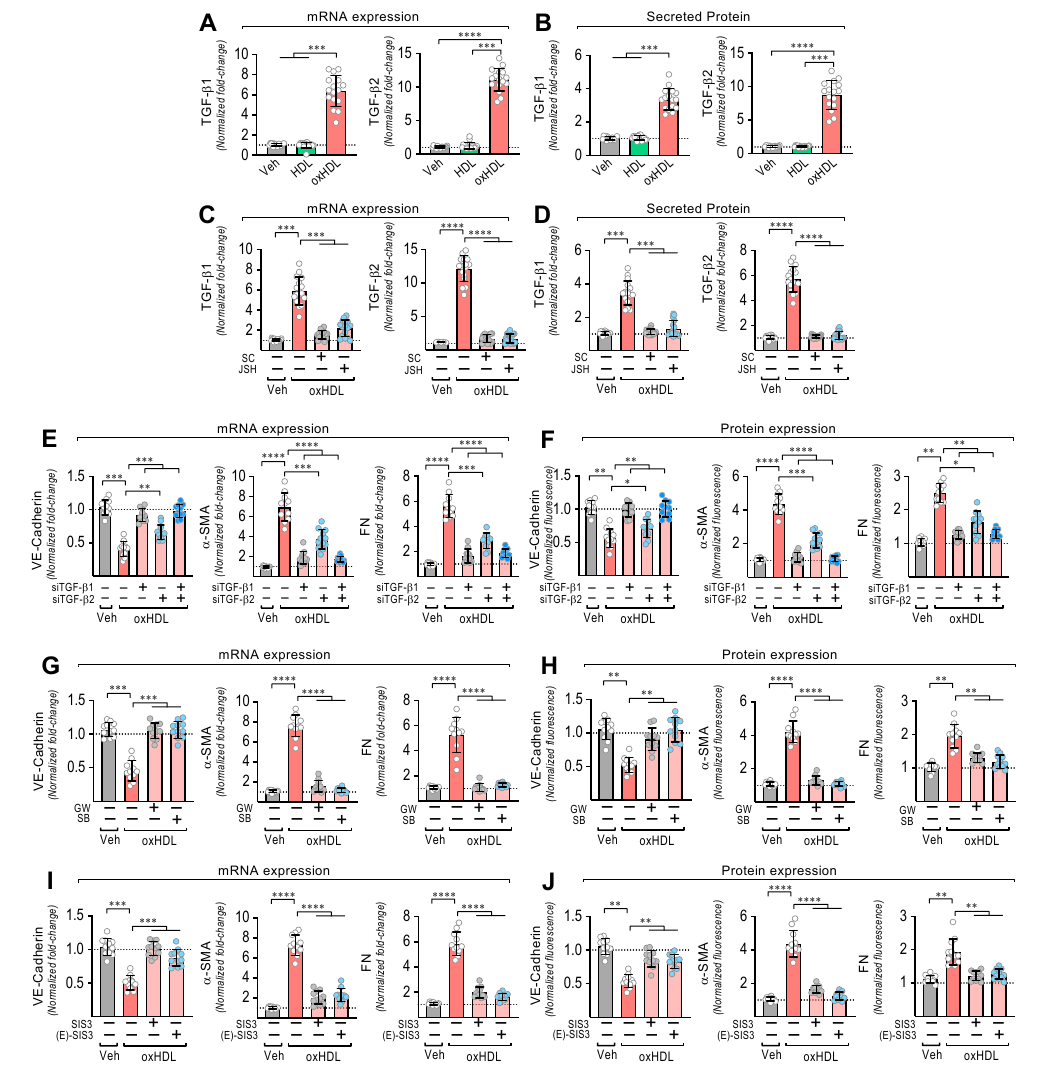
Figure 2. OxHDL induces endothelial fibrosis through the TGF- β 1/2 secretion/ALK-5/Smad protein pathway. ( A , B ) ECs were exposed to vehicle, HDL 50 µ g/mL, and oxHDL 50 µ g/mL for 48 h, and mRNA expression ( A ) and protein secretion ( B ) of TGF- β 1 (left panels) and TGF- β 2 (right panels) were measured. ( C , D ) ECs were exposed to vehicle and oxHDL 50 µ g/mL for 48 h in the absence or presence of the NF- κ B inhibitors SC-3060 (5 µ M) and JSH-23 (30 µ M), and mRNA expression ( C ) and protein secretion ( D ) of TGF- β 1 (left panels) and TGF- β 2 (right panels) were measured. (N = 11). ( E , F ) ECs were transfected with specific siRNA against TGF- β 1 (siTGF- β 1) and TGF- β 2 (siTGF- β 2) or non-transfected for 72 h, and then, cells were exposed to vehicle and oxHDL 50 µ g/mL for 48 h, and mRNA ( E ) and protein ( F ) expression of VE-cadherin (left panels), α -SMA (middle panels), and FN (right panels) was measured. (N = 16). ( G , H ) ECs were exposed to vehicle and oxHDL 50 µ g/mL for 48 h in the absence or presence of the ALK-5 inhibitor GW-788388 (5 µ g/mL) and SB-431542 (30 µ M), and mRNA ( G ) and protein ( H ) expression of VE-cadherin (left panels), α -SMA (middle panels), and FN (right panels) was measured. (N = 16). ( I , J ) ECs were exposed to vehicle and oxHDL 50 µ g/mL for 48 h in the absence or presence of the Smad3 inhibitor SIS3 (10 µ M) and (E)- SIS3 (5 µ M), and mRNA ( I ) and protein ( J ) expression of VE-cadherin (left panels), α -SMA (middle panels), and FN (right panels) was measured. (N = 16). Statistical differences were assessed by one-way analysis of variance (ANOVA) (Kruskal–Wallis) followed by Dunn’s post hoc test. *, p < 0.05; **; p , <, 001 ***, p < 0.001; ****, p < 0.0001. Results are expressed as the mean ±